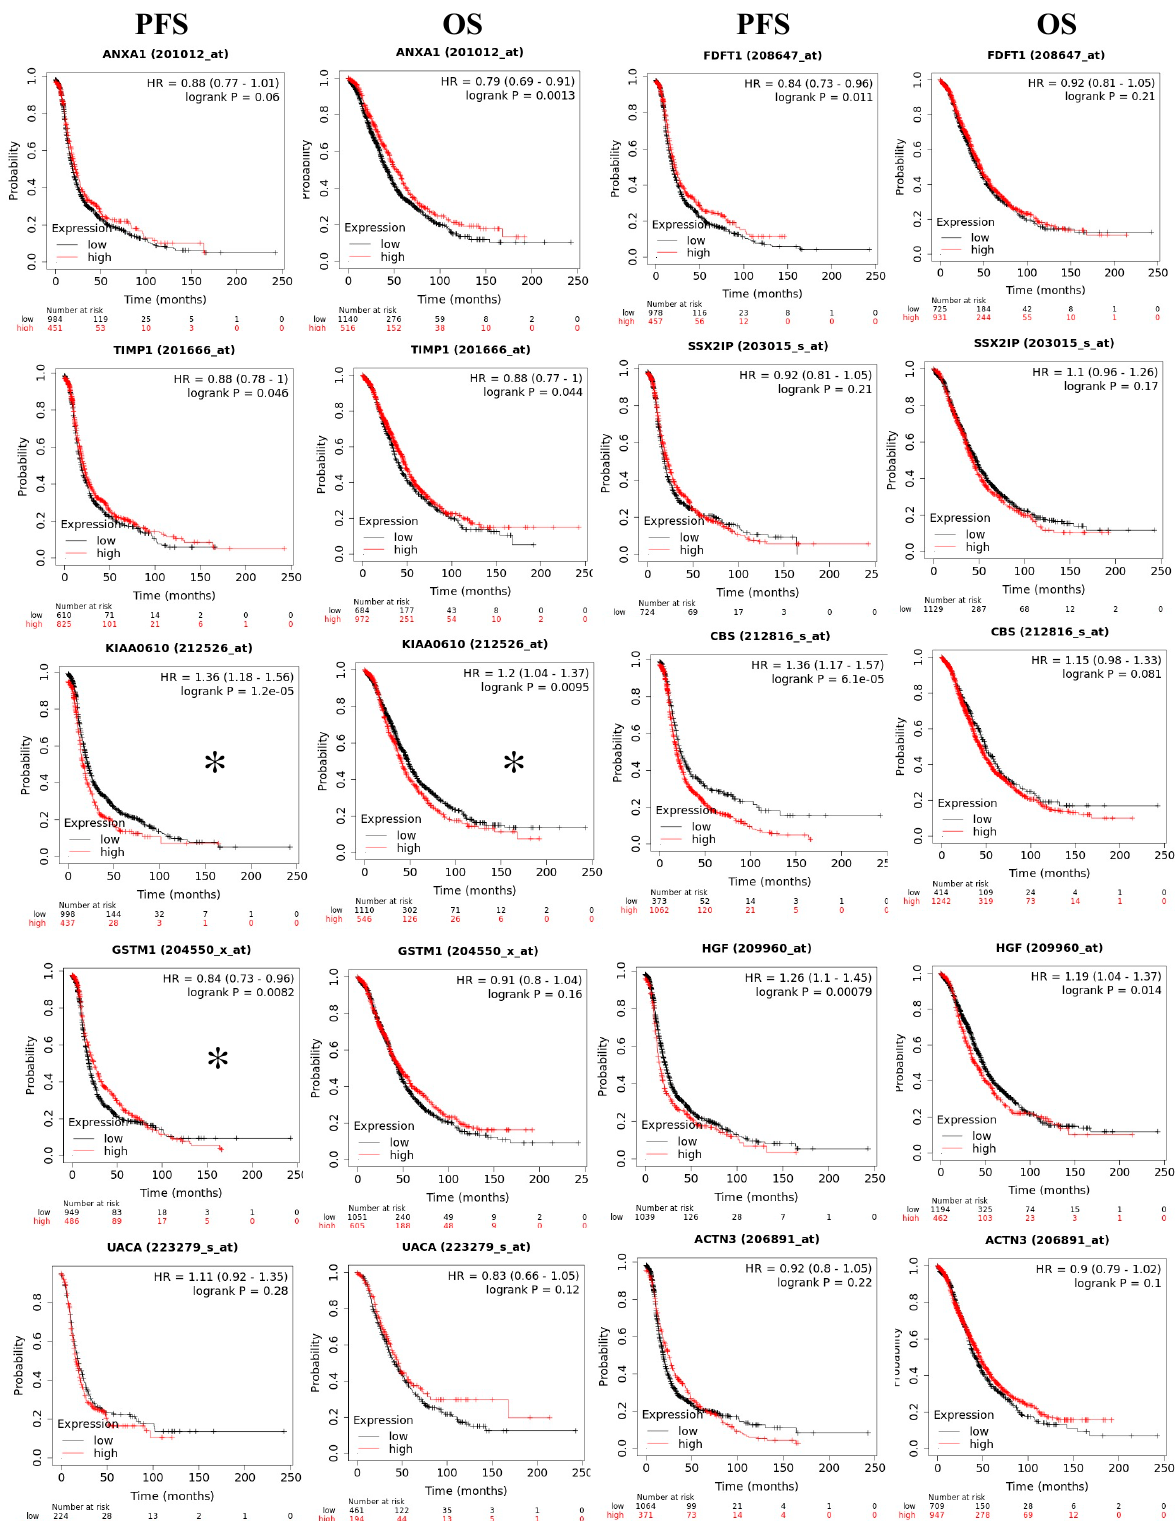
Figure 9. Survival analysis for the 10 common genes deregulated at the RNAseq and protein levels. We found a significant correlation (* p < 0.05) between the OS and PFS and the RNA levels of KIAA0610 (spartin). We also found a significant correlation between the OS (but not the PFS) and the RNA levels for the GSTM1 gene. These correlations were in agreement with our RNAseq results.